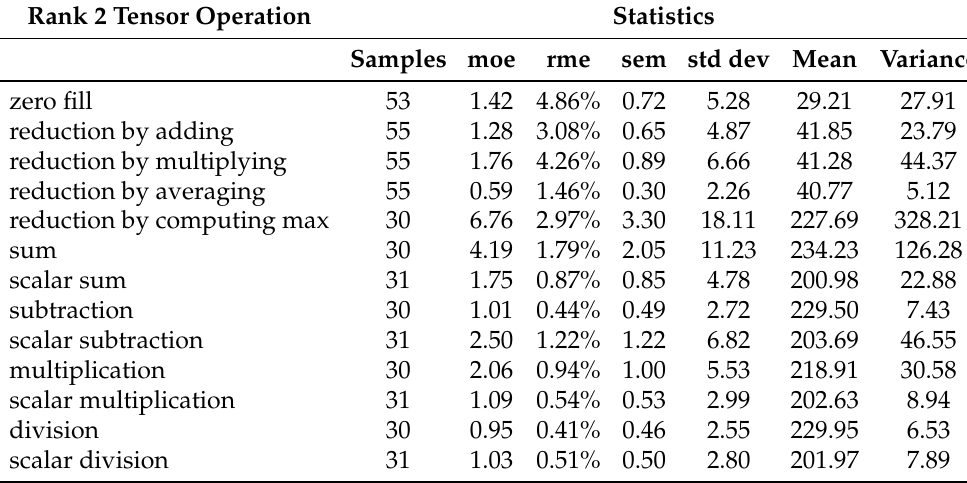
Table 12. Raspberry Pi III B+ benchmark statistics for rank 2 tensor operations with k = 64 (times in ms).